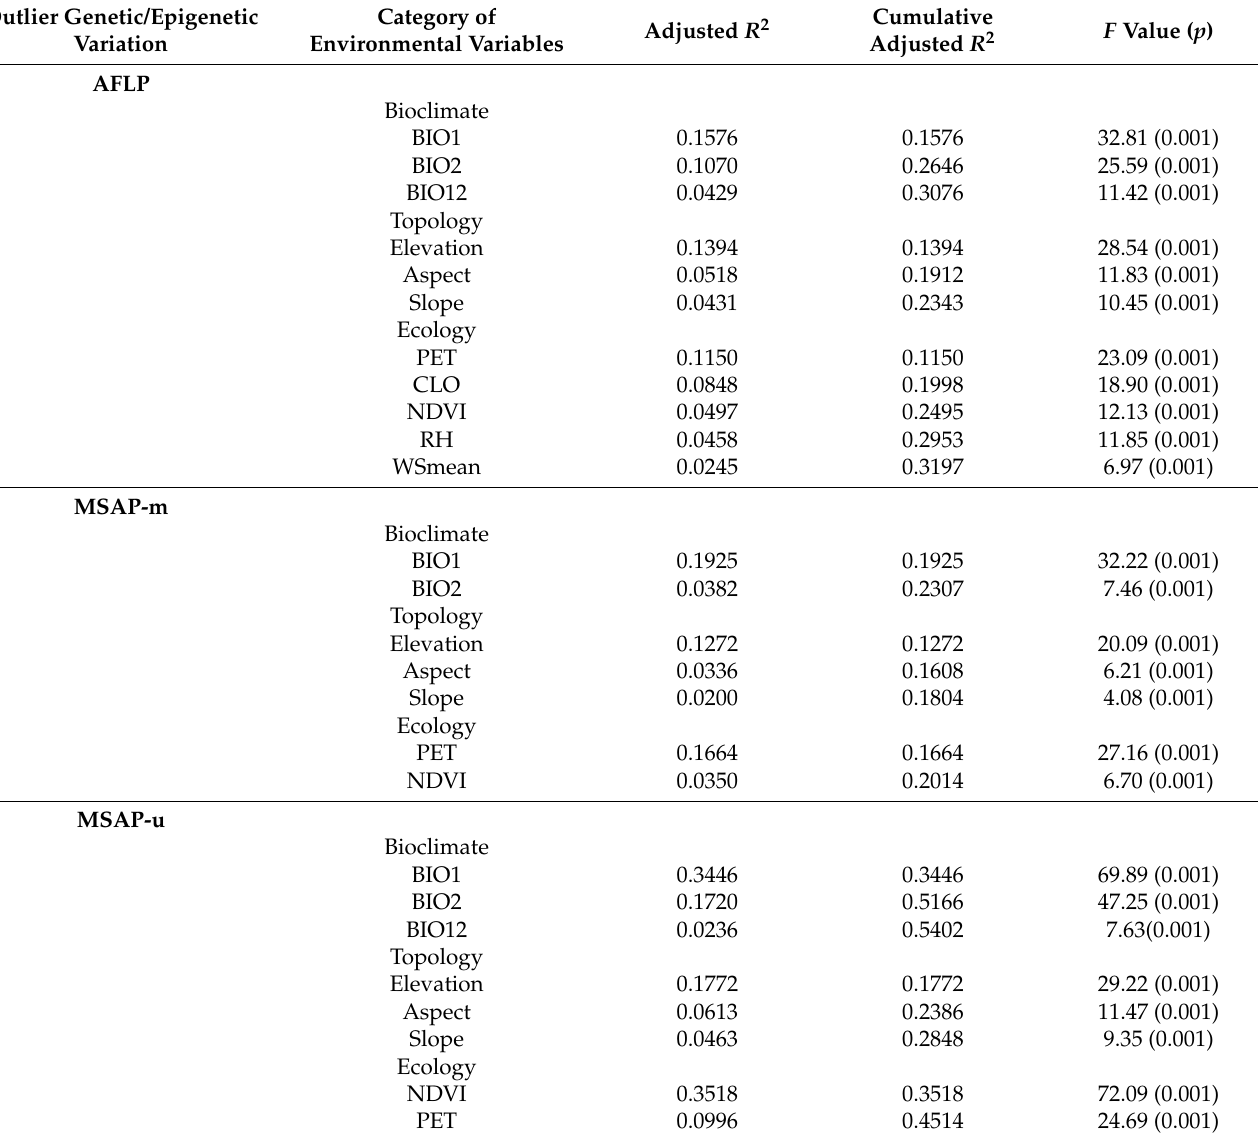
Table 3. Relative contribution (adjusted R 2 ) and F test of environmental variables explaining outlier genetic and epigenetic variations of the Rhododendron pseudochrysanthum complex using a forward selection